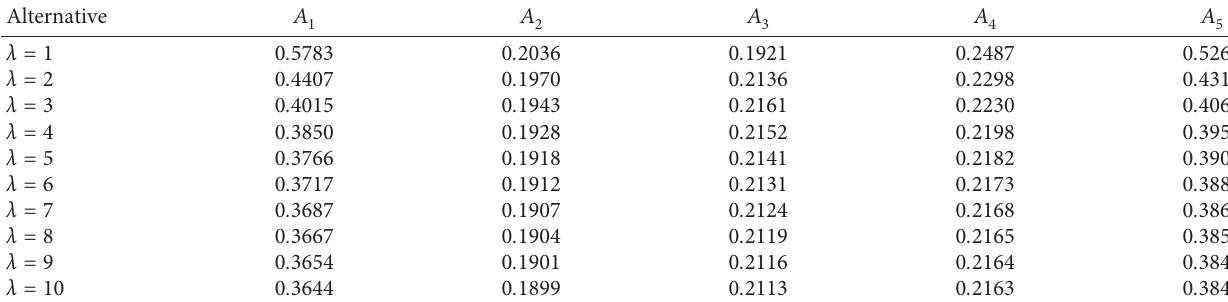
Table 17: The ration CP